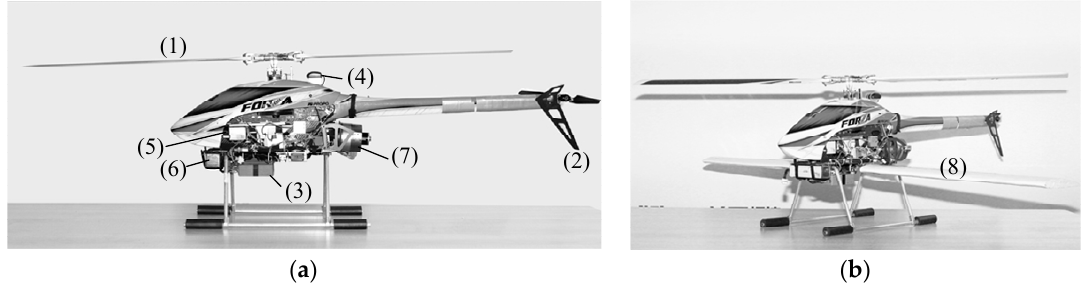
Figure 1. Small-scale compound helicopter (SCH) prototype model. ( a ) Configuration D; ( b ) Configuration WD. (In the Figures: (1) Main rotor; (2) Tail rotor; (3) Onboard computer; (4) GPS antenna; (5) Main batteries (×2); (6) Ducted fan batteries (×2); (7) Ducted fan; (8) Wings).